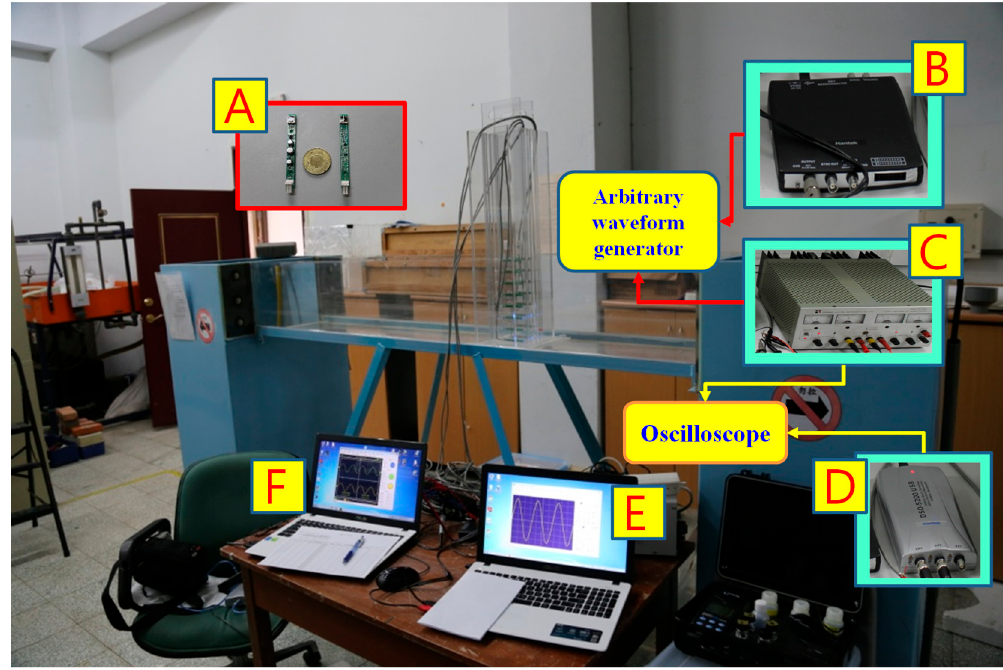
Figure 2. Experimental setup consisting of A : VLC sensor (Tx & Rx); B , C , D : waveform signal generator; E : input waveform signal monitoring; F : sensor signal response monitoring.